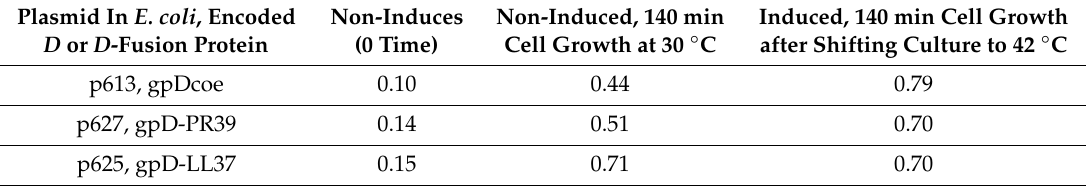
Plasmid In E. coli , Encoded